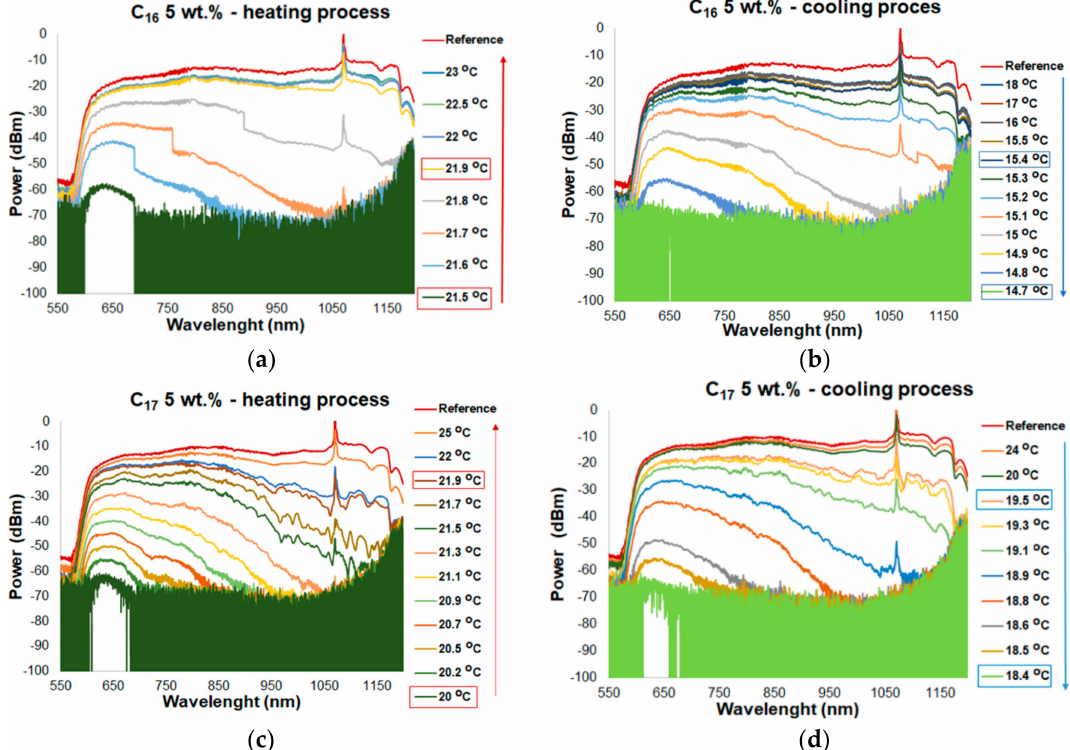
Figure 9. Transmission of a tapered optical fiber in the range of 550–1200 nm for di ff erent temperatures for: ( a ) heating process for C 16 + 5 wt.% ZnS:Mn NPs, ( b ) cooling process for pure C 16 + 5 wt.% ZnS:Mn NPs, ( c ) heating process for pure C 17 + 5 wt.% ZnS:Mn NPs, and ( d ) cooling process for pure C 17 + 5 wt.% ZnS:Mn